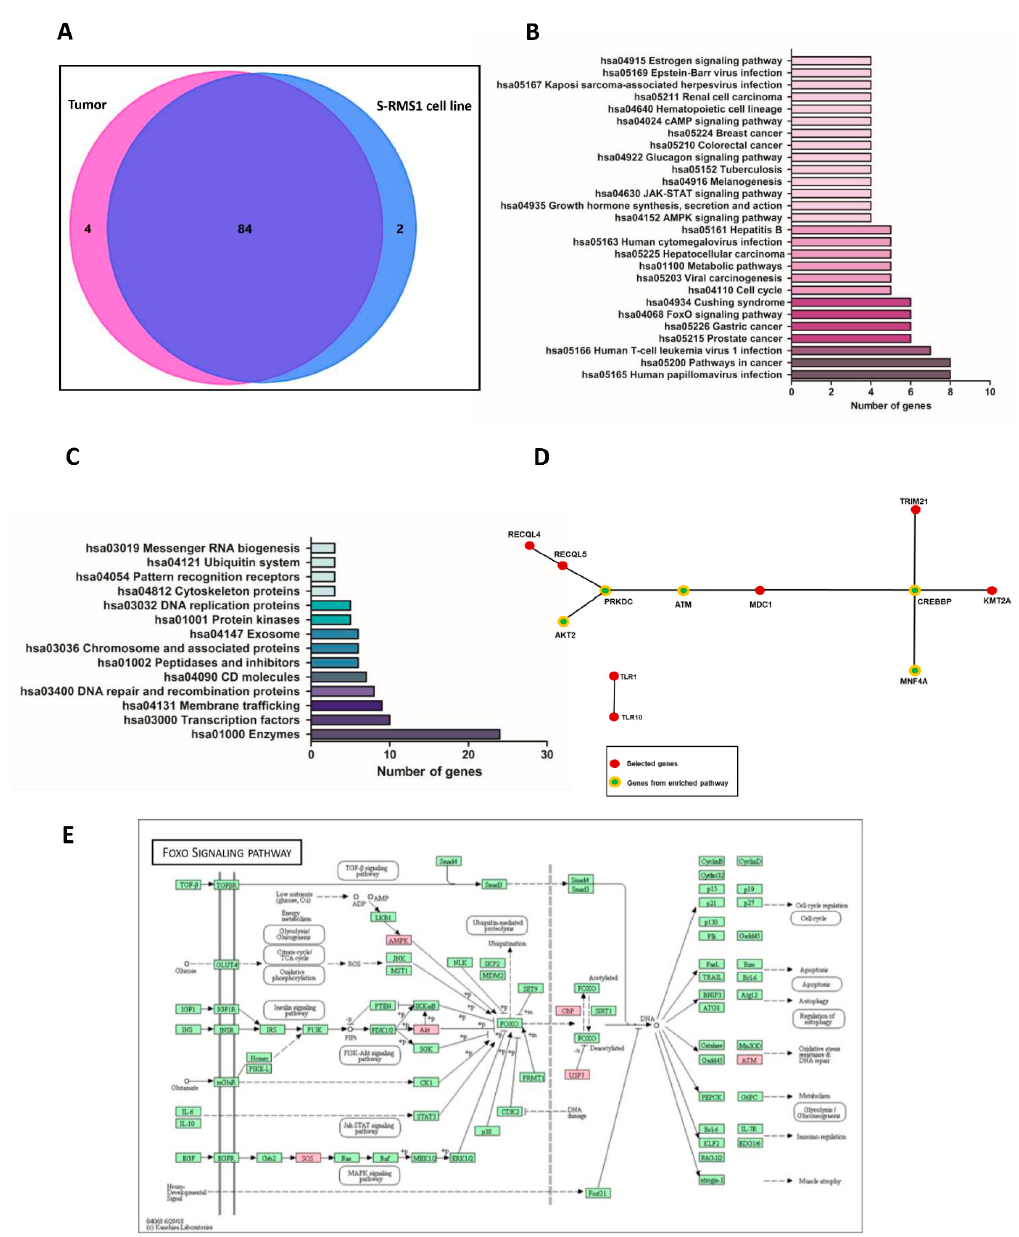
Figure 2. Tumor and S-RMS1 cell line whole genome resequencing and bioinformatic analysis. ( A ) Venn diagram analysis performed with FunRich software. The pink circle represents the tumor at diagnosis dataset; the blue circle represents the S-RMS1 dataset. The intersection of the two circles represents overlapping genes with variants (SNPs and indels) among the two datasets. ( B ) Gene ontology (GO) terms and KEGG pathways analysis using 84 common genes reporting genomic variants between the two datasets (tumor at diagnosis and S-RMS1 cell line). The graph shows pathways where at least 4 genes of the 84 that are common to the two samples were implicated. ( C ) Graphical representation of functional categories for the 84 common genes. Categories with at least 3 genes of the dataset are reported. ( D ) Interaction pathway performed with FunRich Software determined by the analysis of the 84 genes with genomic variants shared by the tumor at diagnosis and S-RMS1 cell line. Red circles represent the gene with at least one interaction and green circles the genes with more than one interaction belonging to enriched pathways. ( E ) FoxO signaling pathway in KEGG pathway enrichment. Red boxes indicate the genes presenting genomic variants from the list of 84 common